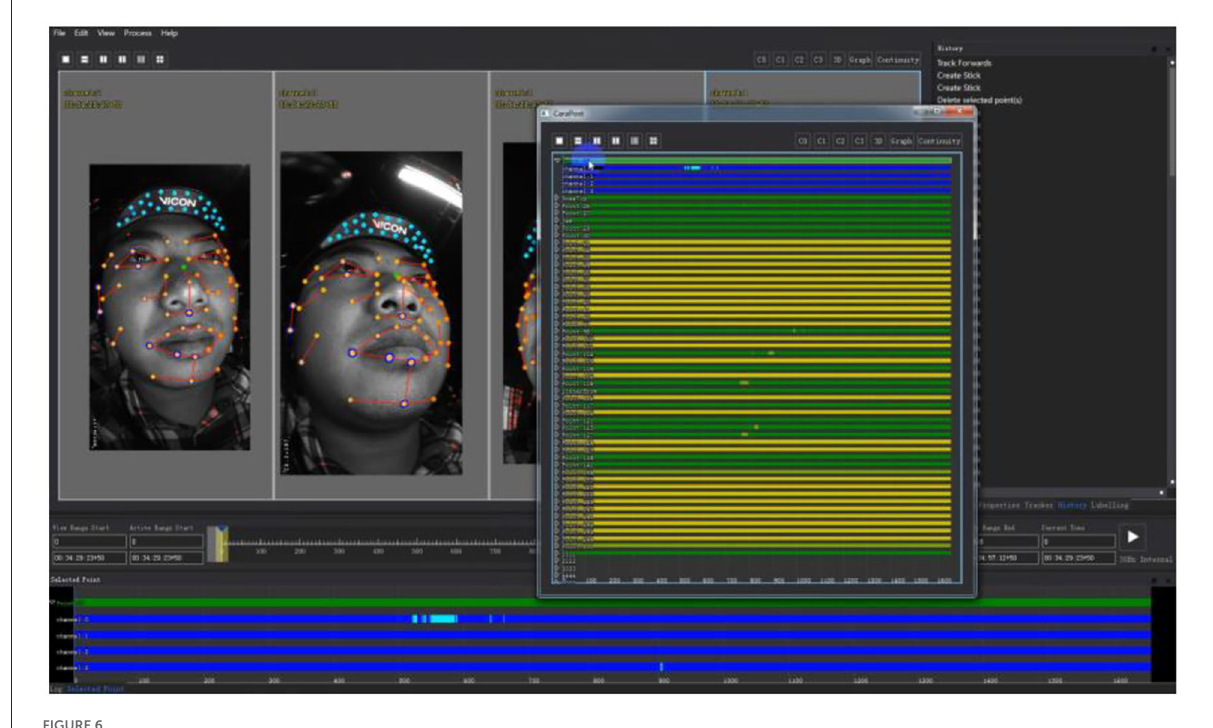
FIGURE6 The process of data repair (The Image from Shengyin